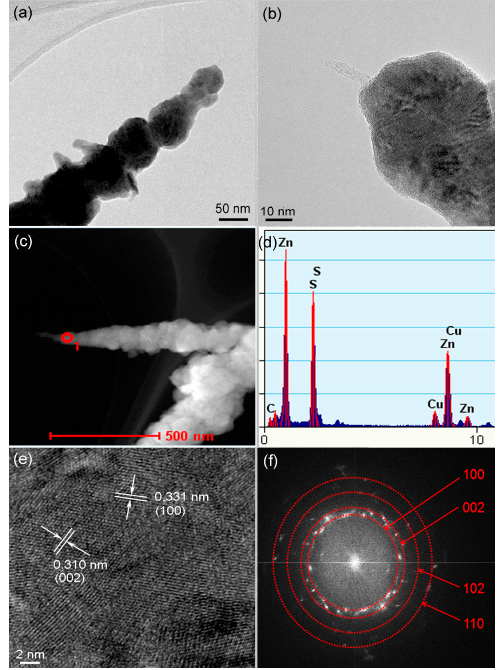
Figure 2. ( a , b ) TEM images; ( c ) high-angle annular-dark-field TEM (HAADF-TEM) image; ( d ) EDS spectrum; ( e ) high-resolution TEM (HRTEM image; and ( f ) Fourier transform pattern of the SWCNT–ZnS nanocables.